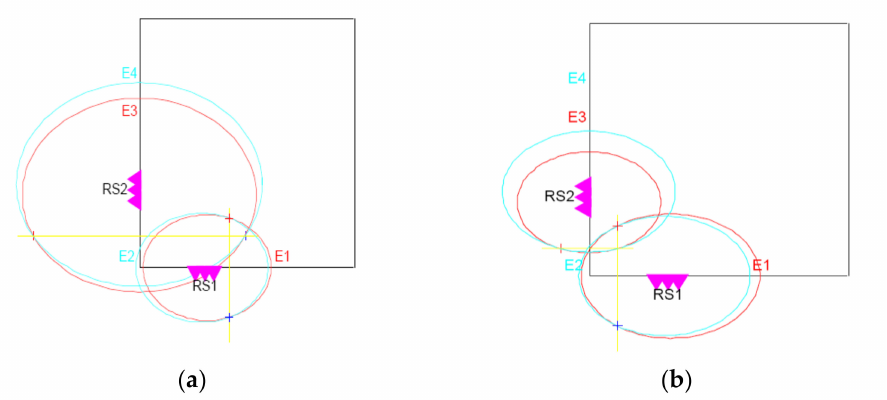
Figure 5. Position of lines of RS1 and RS2 sets in the points ( a ) τ = 150 and ( b ) τ = 225. The analog expression E 4 RS 2 represents ellipse No. 4 in radar set RS2, with foci in the position of the transmitter Tx B and in the position of the receiver Rx B2 . The line drawn through the intersections of the ellipses represents the 2nd line using the method of lines. The number of real intersections of ellipses in each of the investigated points was = 4. Other ellipse intersections can be found in this way. Finding the intersections of ellipses created by combinations of ellipses of different sets and their use is described in